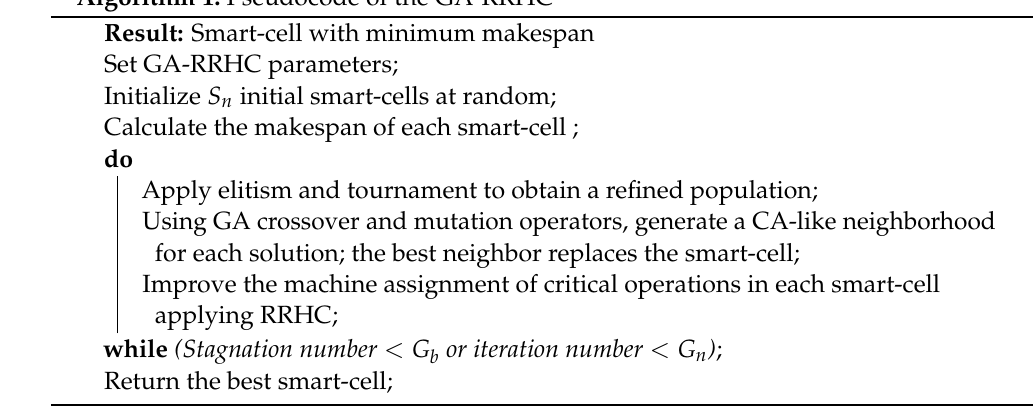
Algorithm 1: Pseudocode of the